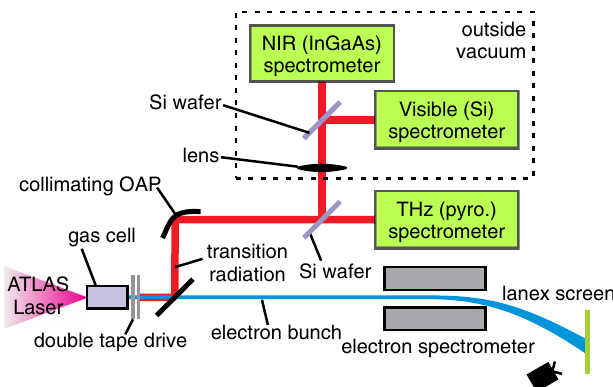
FIG. 6. Experimental setup for characterization of coherent transition radiation across the visible, near-infrared, and terahertz ranges of the electromagnetic spectrum. See text for